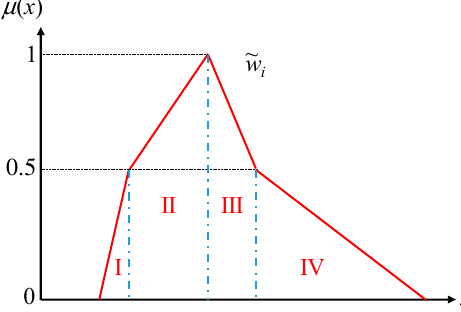
Figure 6. Decomposing a fuzzy priority estimated using PLFGM into several non-normal TrFNs. Table 3. Corner data of the non-normal TrFNs.